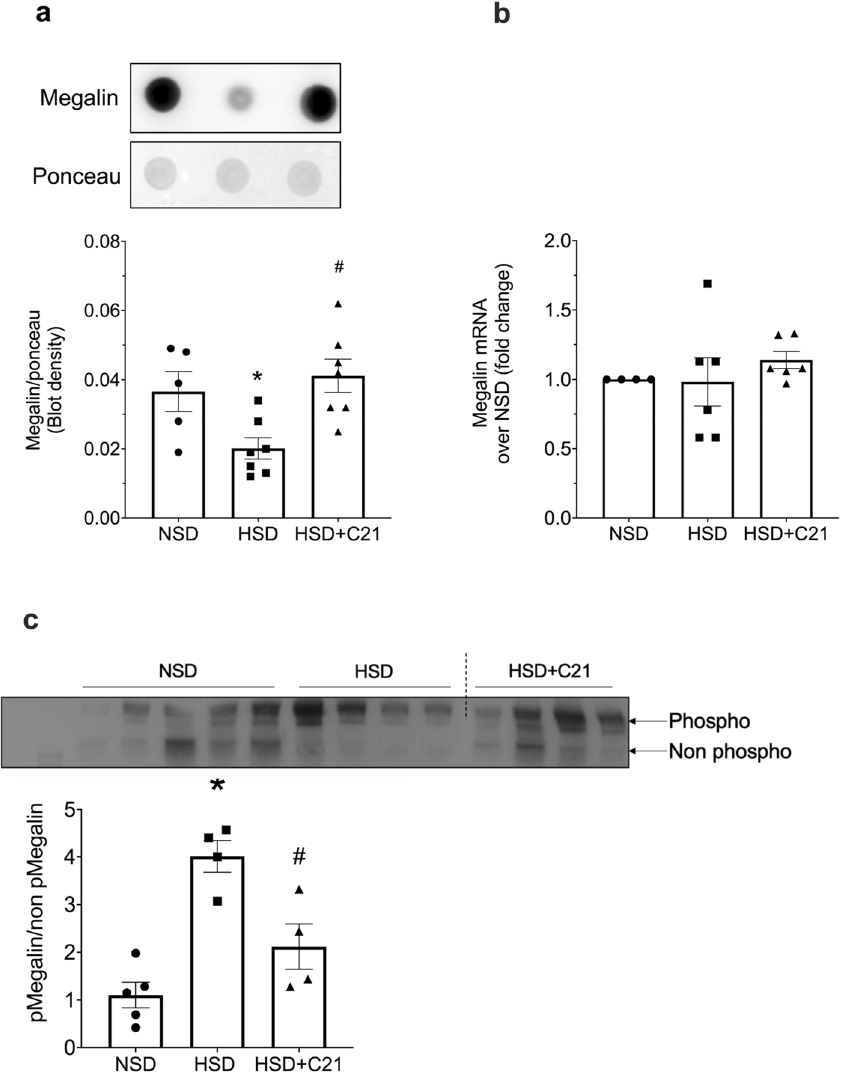
Figure 2. Expression of megalin through dot blot ( a ), mRNA expression of megalin ( b ) and western blot of phosphorylated and unphosphorylated-megalin ( c ). Densitometry was normalized by ponceau ( a ) and the ratio of phospho to non-phospho megalin expression on phostag gel is shown in 2c. Lanes 10 and 11 from Fig. 2c has been removed. Values are represented as mean ± sem; and one-way ANOVA followed by Fisher’s LSD test respectively ( b , c ). * p < 0.05 versus NSD and # p < 0.05 versus